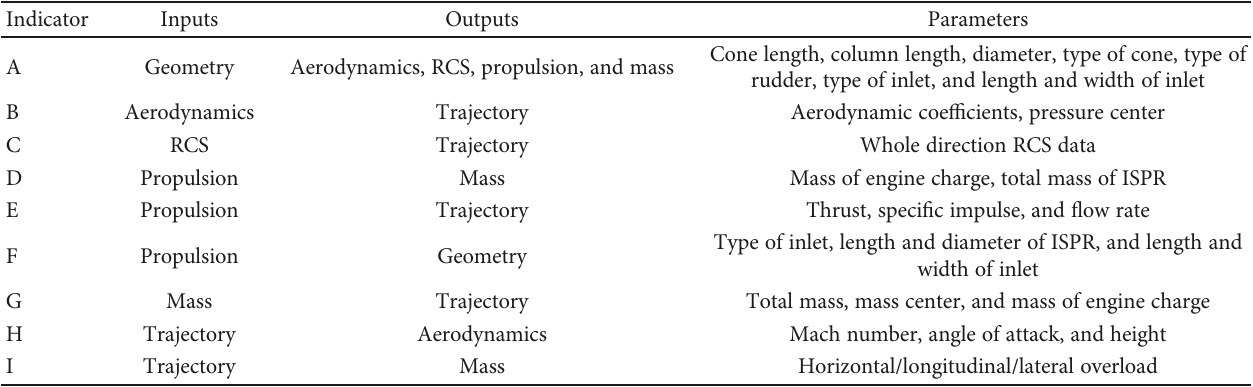
Table 3: All interaction parameters between the discipline codes.